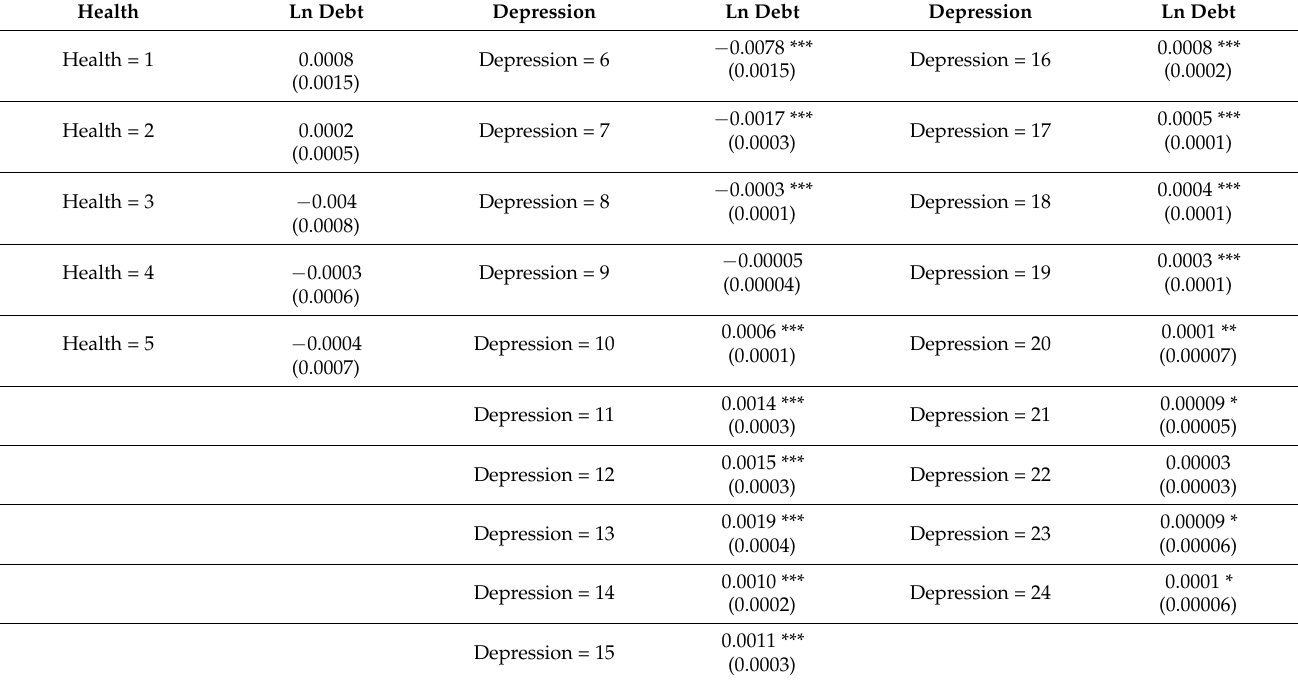
Table A5. Marginal effects of household debt in high education subgroup.